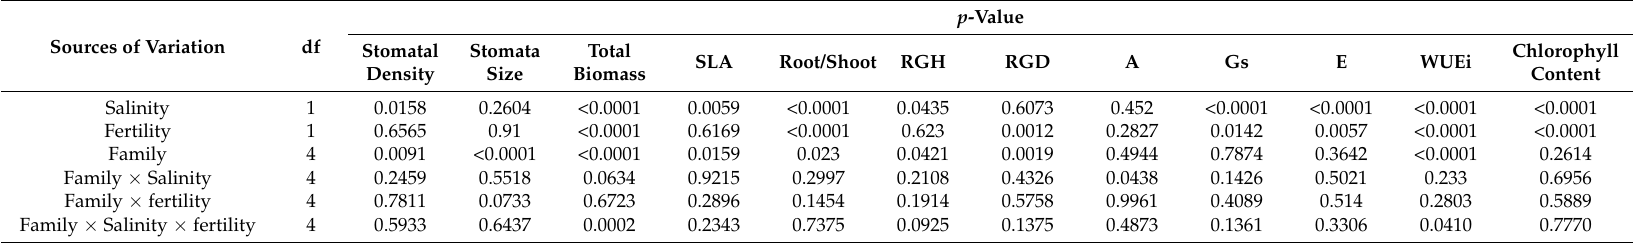
Table 3. Analysis of variance (ANOVA )results for the response of different Senegalia senegal families to salinity and fertility for stomatal density and size, total biomass, specific leaf area (SLA), root/shoot, leaf gas exchanges (net photosynthetic rate (A), stomatal conductance (G s ), transpiration (E), and intrinsic water use efficiency (WUE i )), relative growth of height (RGH) and diameter (RGD), and chlorophyll content following a drought